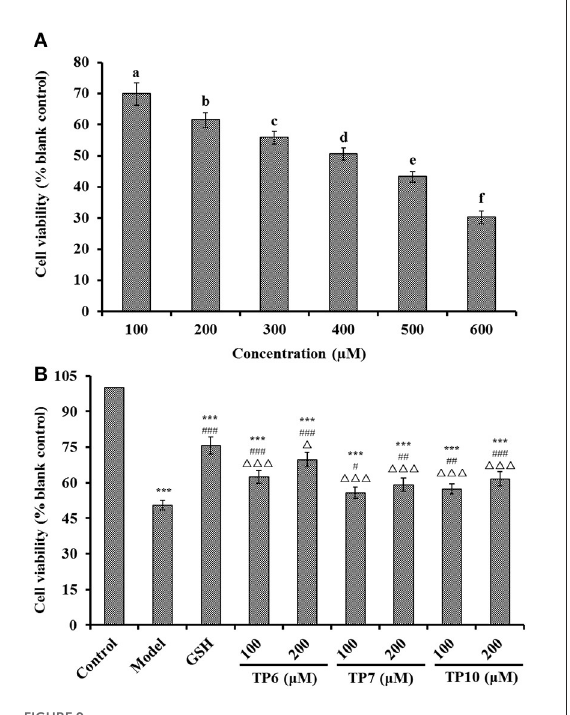
FIGURE9 Effects on the viability of different H 2 O 2 concentration (100–600 µ M)-treated HUVECs (A) and TP6-, TP7-,